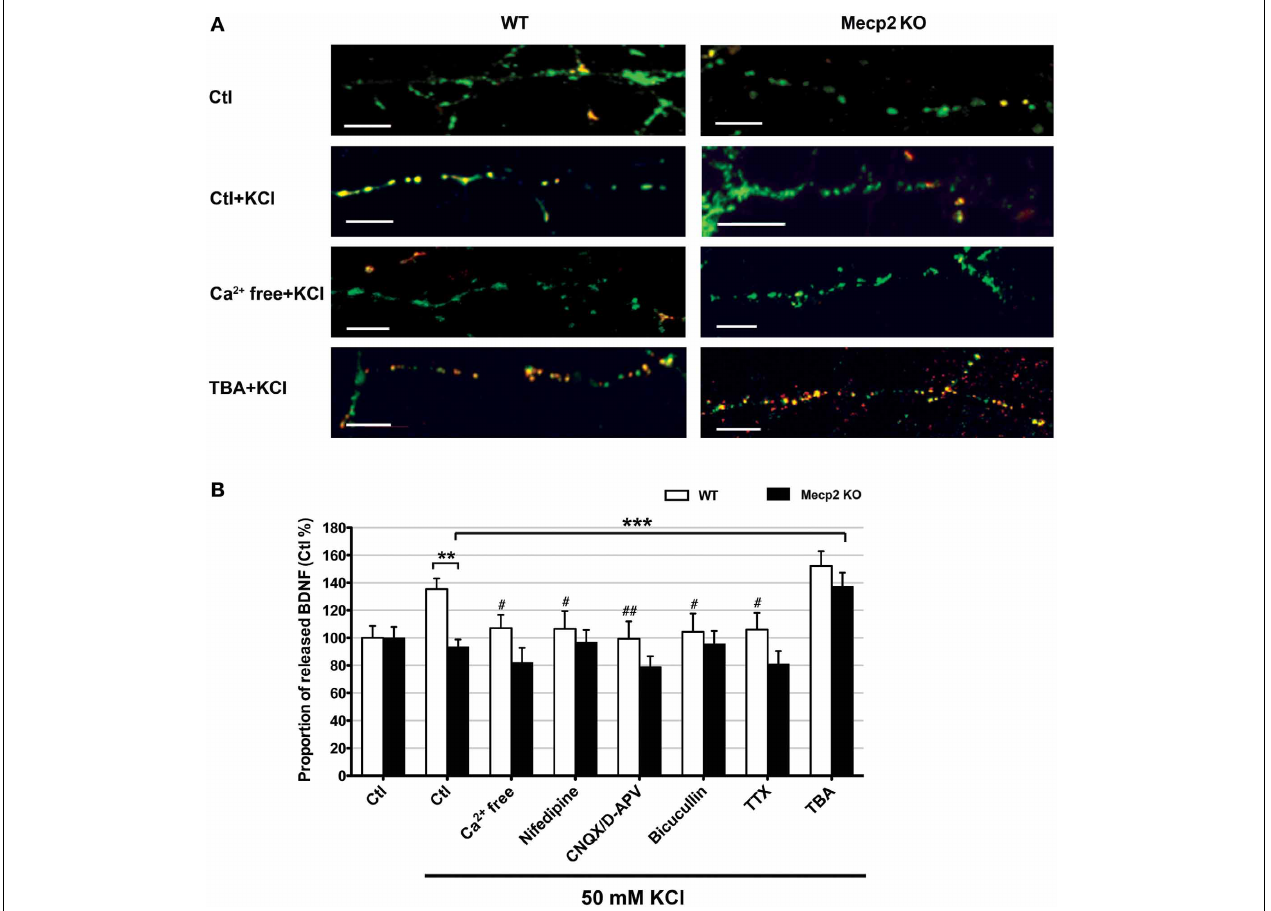
FIGURE 4 | Activity-dependent release of BDNF-YFP is impaired in Mecp2 knockout neurons. (A) Representative examples of BDNF release in wildtype and Mecp2 knockout neurons: no treatment, stimulated with KCl, stimulated with KCl in the absence of extracellular Ca 2 + and stimulated with KCl upon TBA treatment; scale bar = 10 μ m. BDNF-YFP is shown in green, while YFP immunoreactivity is shown in red. Yellow pixels represent colocalization of green and red pixels, i.e., secreted BDNF. (B) Proportion of released BDNF per total BDNF upon